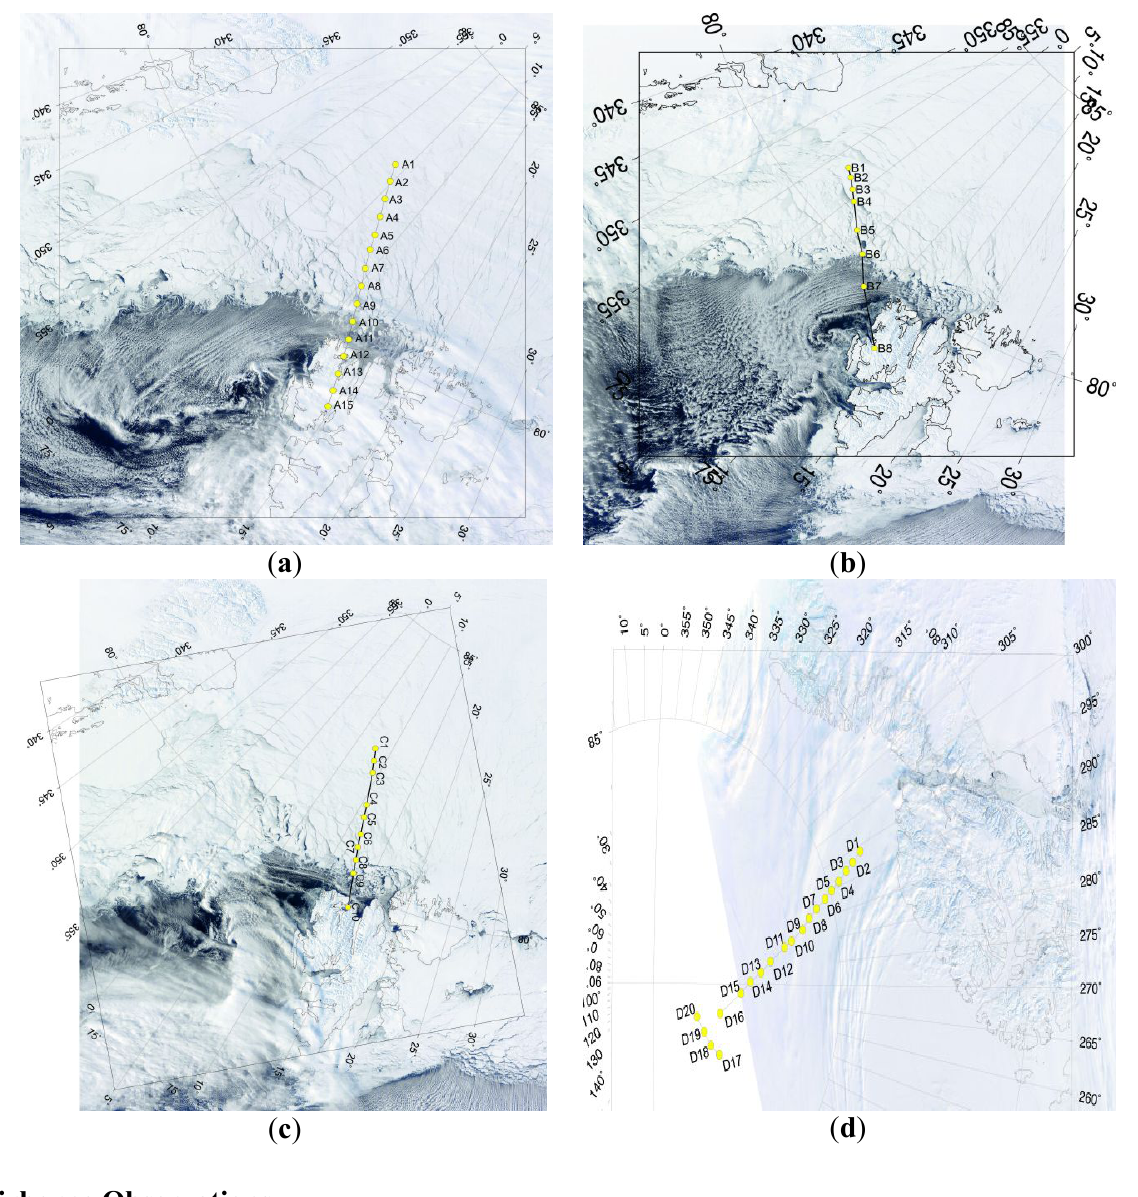
Figure 4. Moderate Resolution Imaging Spectroradiometer (MODIS) high resolution images (250 m) of the sea ice conditions along the flight track on ( a ) 3 April, 13:15 UTC, ( b ) 5 April 2009, 13:05, ( c ) 6 April 2009, 13:45, and ( d ) 10 April, 19:55. The yellow dots indicate the location of the dropsonde launches (for coordinates and times see Tables 1–4). The gray lines represent the flight tracks. These images taken by the TERRA satellite were obtained from the NASA/GSFC MODIS Rapid Response web site in 250 m resolution, showing the true color spectral bands 1-4-3. The overlaid maps were drawn using the Generic Mapping Tools from